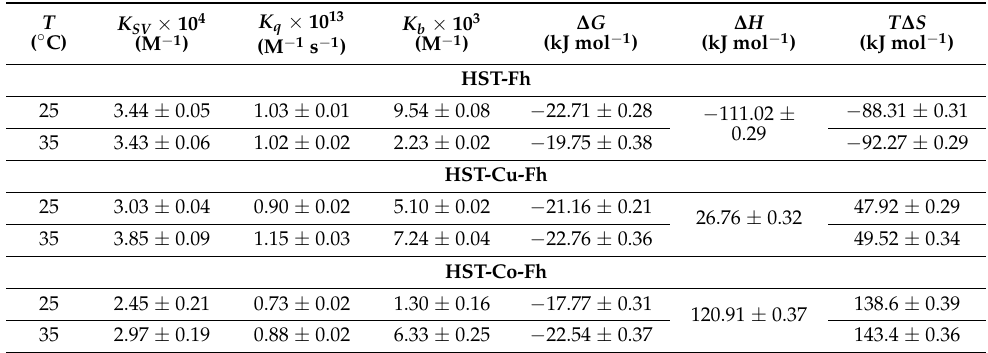
Table 1. The binding parameters of the interaction of Fh-NPs with